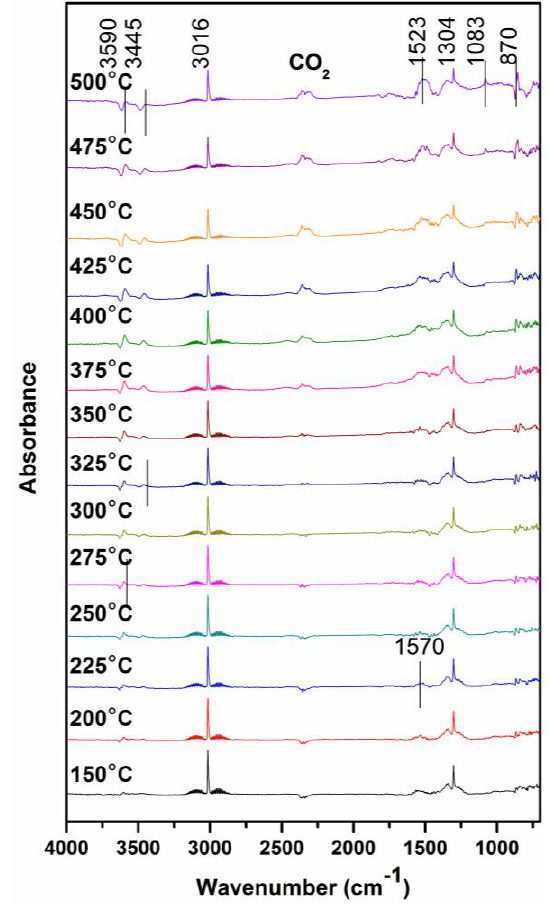
Figure 14. In situ DRIFTS spectra of micro steady state.